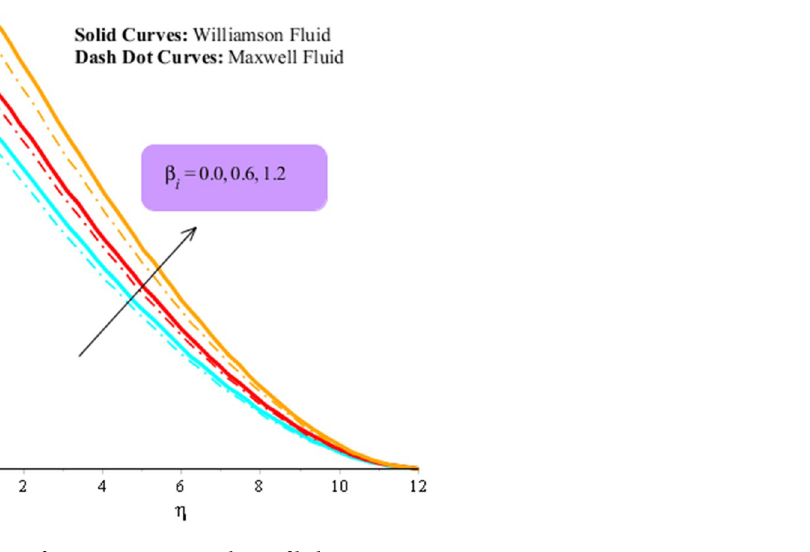
Figure 5. Influence of β i versus primary velocity